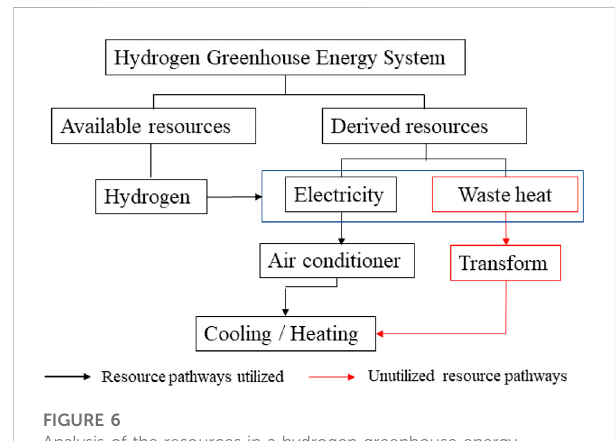
FIGURE 6 Analysis of the resources in a hydrogen greenhouse energy